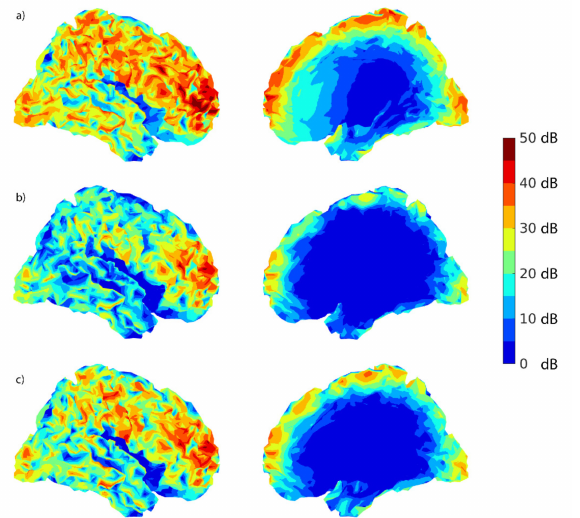
Figure 8. Lateral and sagittal view for ( a ) sensor-level SNR1 cortical maps (in dB) on the right hemisphere, ( b ) source-level SNR2 cortical maps (in dB), regularization 0%, and ( c ) source-level